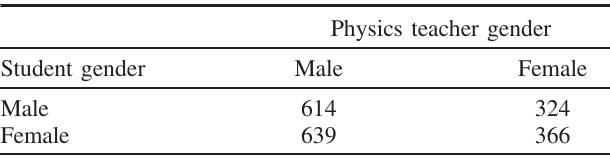
TABLE I. Cross-table frequencies for gender of teacher and